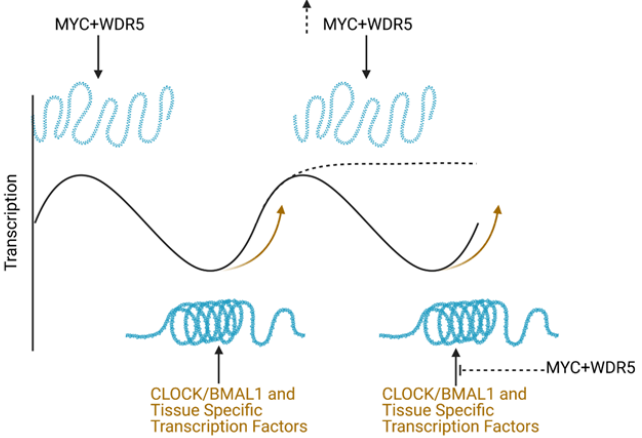
Figure 2. MYC and CLOCK-BMAL1 may both regulate chromatin state. Endogenous MYC facilitates transcription in a manner dependent on chromatin availability of WDR5, regulation of chromatin by CLOCK/BMAL1 complex, and other tissue specific transcription factors. This keeps chromatin open in an oscillatory fashion. When the clock is disrupted and MYC levels are increased, competition with CLOCK-BMAL1 may affect chromatin and cause the chromatin state to cease oscillation and remain more open, resulting in a higher level of transcription. Black arrows indicate MYC (in cooperation with WDR5) or CLOCK-BMAL1 contributing to chromatin state, solid black line indicates oscillatory transcription, orange arrows indicate how CLOCK-BMAL1 and tissue specific transcription factors guide this oscillation, black suppression arrow with dotted line indicates MYC (in cooperation with WDR5) interfering with CLOCK-BMAL1 control of chromatin, and dotted line indicates transcriptional oscillation (disrupted by MYC) dampening and plateauing. Created with BioRender.com, publication license acquired on 16-7-21.